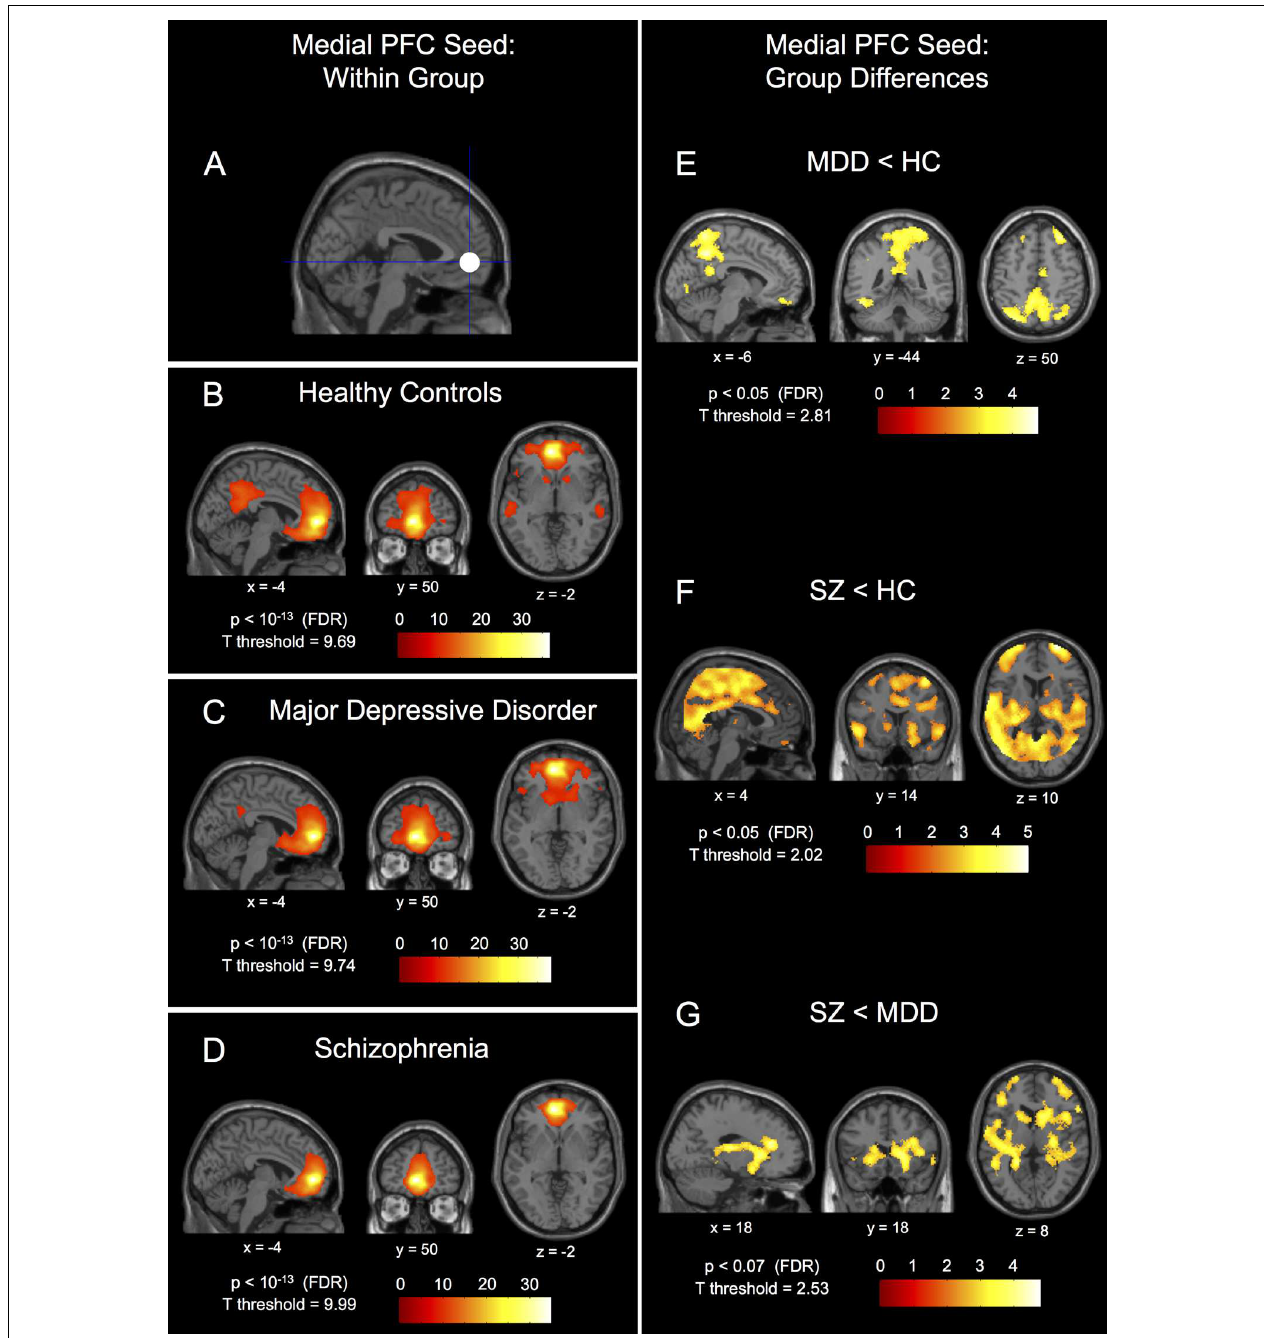
FIGURE 1 | Within-group connectivity to the medial prefrontal cortex seed and between-group differences. The 10 mm radius medial prefrontal cortex (PFC) seed ( − 1, 49, − 2) shown in (A) and it’s within-group connectivity shown below for healthy controls (HC) in (B) , major depressive disorder patients (MDD) in (C) , and schizophrenic patients (SZ) in (D) . Group differences in connectivity are shown for MDD < HC in (E) , SZ < HC in (F) , and SZ < MDD in (G) . Seed coordinates and image labels are in MNI space. All p -value thresholds were set for display purposes only.